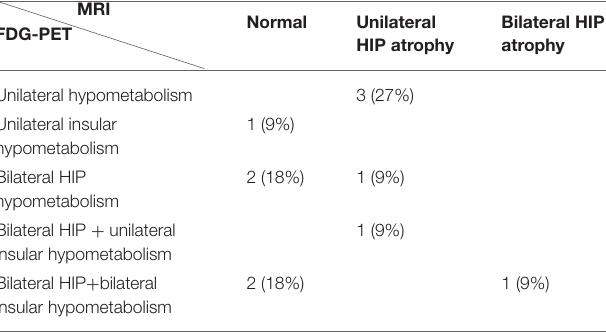
TABLE 3 | Correlation between MRI findings and FDG-PET findings in patients with focal epilepsy + GAD ab. MRI Normal Unilateral Bilateral HIP FDG-PET HIP atrophy atrophy Unilateral hypometabolism 3